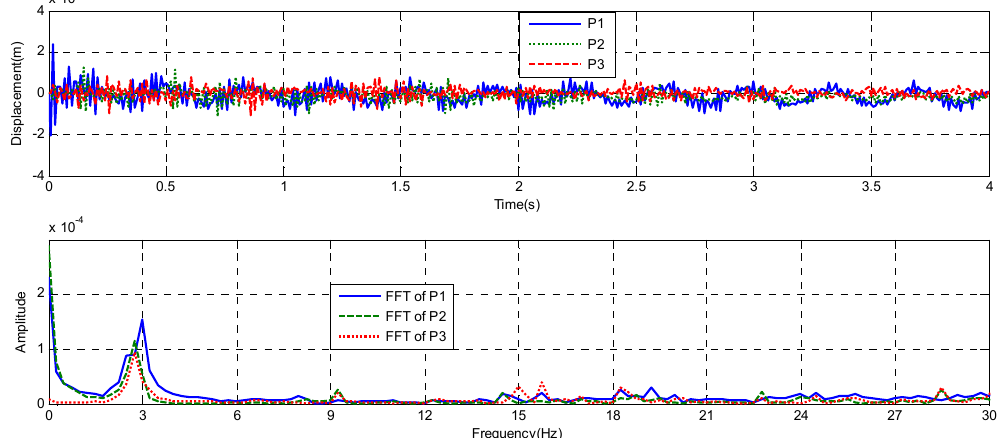
Figure 22. The plot of displacement time history when the thickness is 0.03 m, P12.